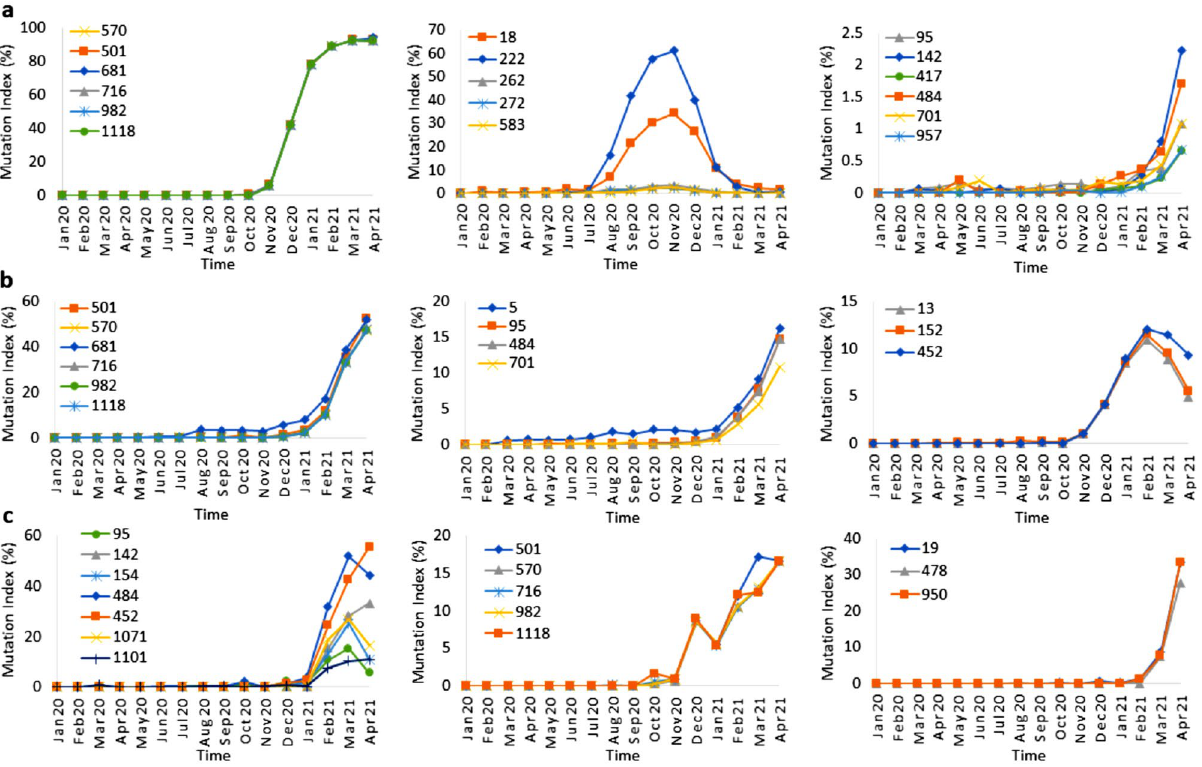
Figure 5. Mutation index profile from ( a ) UK, ( b ) US and ( c ) from India for SARS-CoV-2 between Jan 2020 to Apr 2021. The data for the D614G is not shown here as it is a dominant mutation since the onset of the COVID- 19 pandemic, as shown in Table